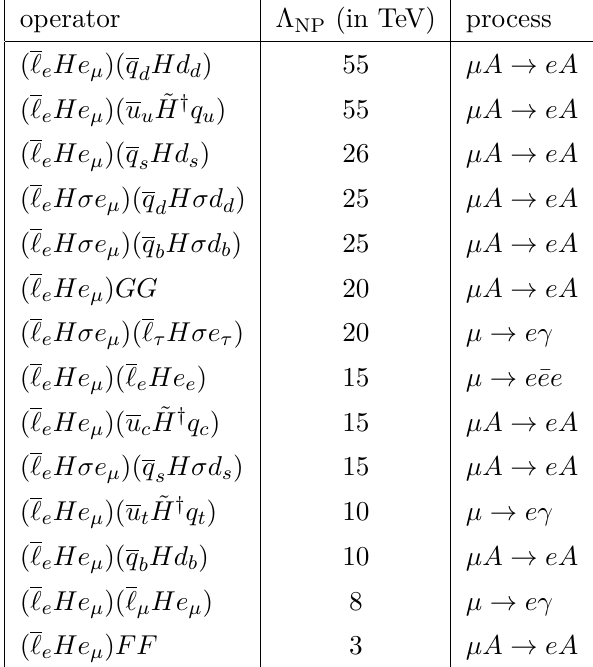
Table 5 . Dimension eight operators which induce at low energy four-particle contact interactions that do not arise at dimension six. The operators are represented schematically in the first column, and the second column gives the scale Λ up to which the process of the third column (with NP upcoming sensitivity) could probe coefficients . 1 . (The estimate for ( ‘ ) FF is from [47].) e He µ